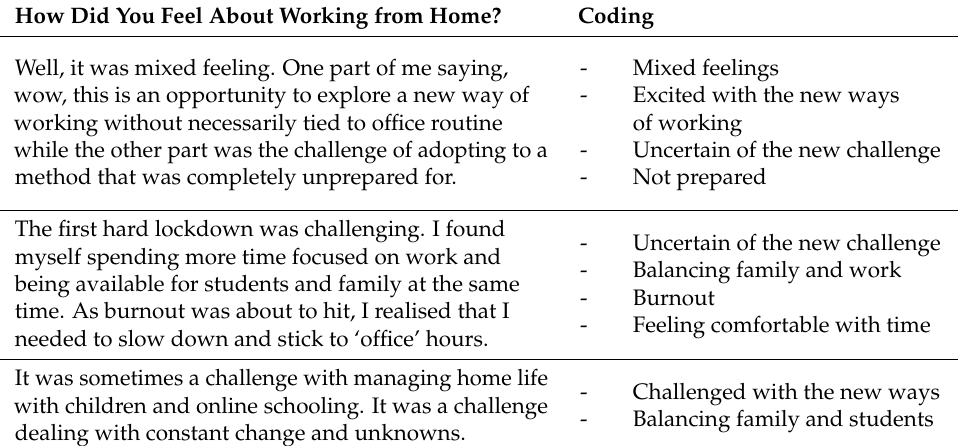
Table 2. Initial coding of data